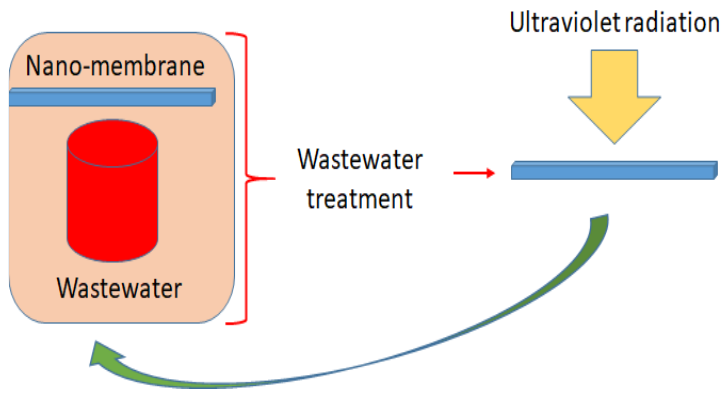
Figure 8. Schema of the nanomembrane procedure for wastewater